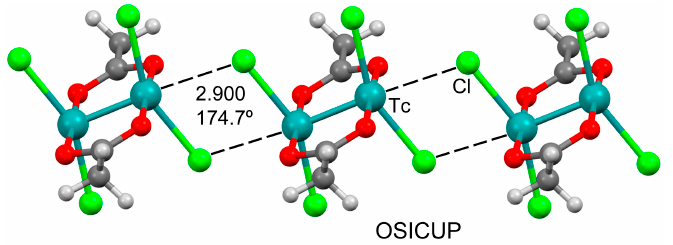
Figure 10. Ball and stick representation of the X-ray structure OSICUP. Counter-cations omitted. Distance in Å. Color code: Carbon grey, Technetium teal, Oxygen red, Hydrogen light grey.